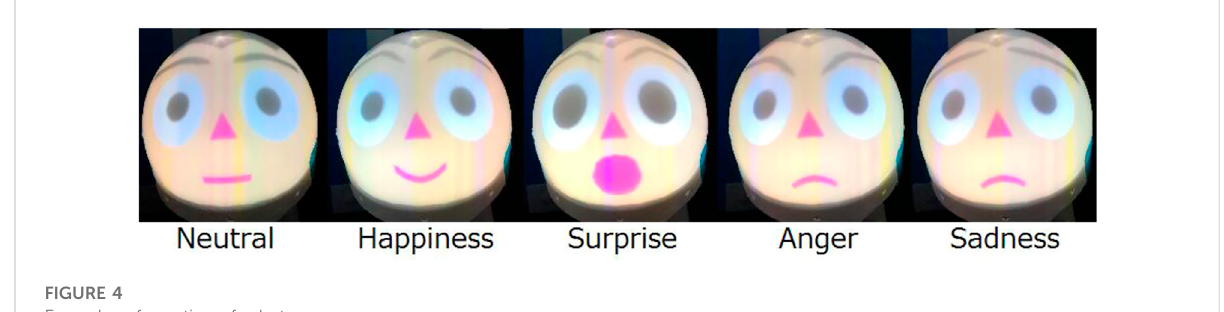
FIGURE 4 Examples of emotion of